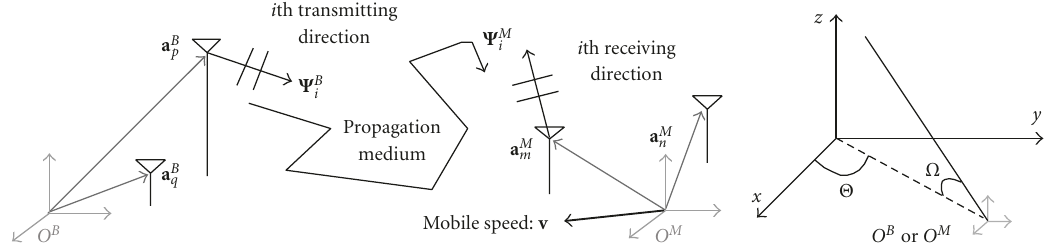
Figure 1: 3D space . One pair of BS-MS antennas in the 3D space: p th ( q th) antenna element of BS and m th ( n th) antenna element of MS in their local coordinate axis in a 3D wave propagation environment. Azimuth and elevation angles in the 3D propagation